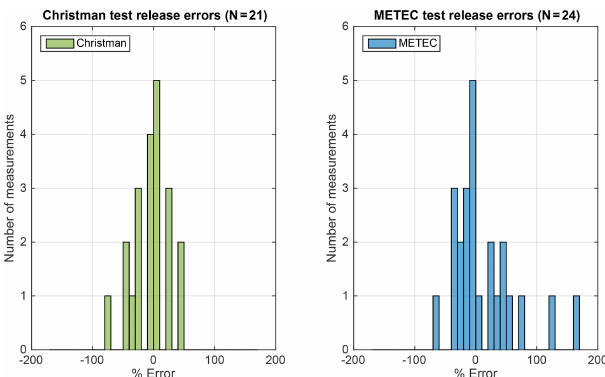
Figure 3. Histogram of percent error of the OTM 33A flux estimate for both Christman and METEC test releases. Data are binned in 10% error bins. Positive percent error corresponds to OTM 33A overestimating the known release rate.